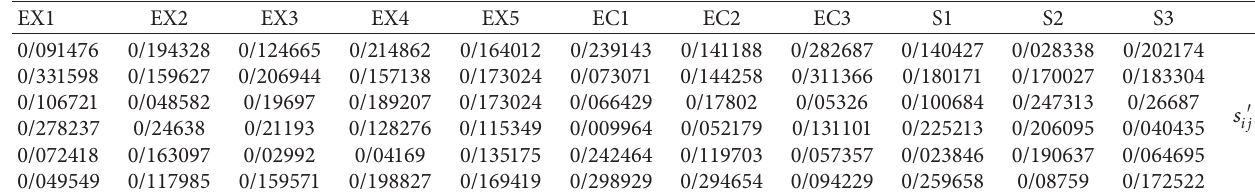
Table 6: Value S ′ .